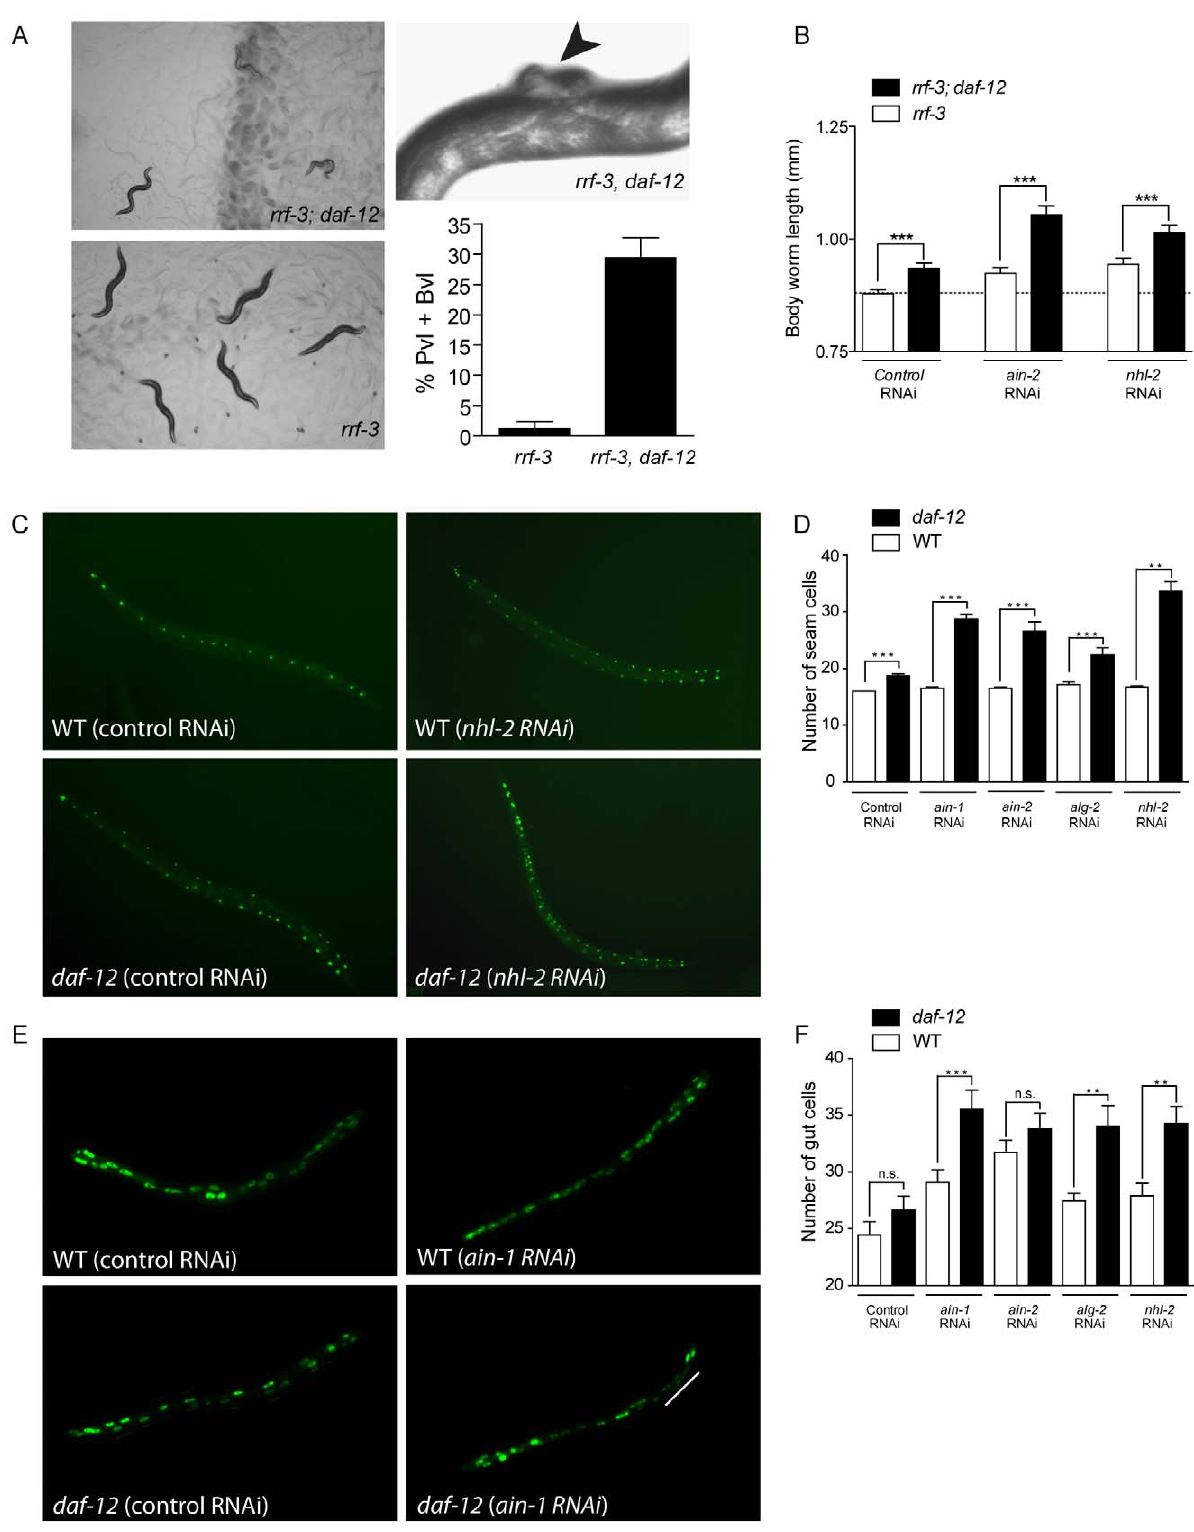
Figure 6. daf-12(0) worms are sensitized to changes in miRISC activity. ( A ) (Left panels) Images of ain-1 RNAi treated rrf-3 or rrf-3; daf- 12(rh61rh411) worms. (Upper right) Photo showing protruding vulva phenotype (arrow). Graph showing effects of ain-1 RNAi treatment on vulva development. ( B ) Body length was analyzed in rrf-3 or rrf-3; daf-12(rh61rh411) worms treated with ain-2 or nhl-2 RNAi. ( C ) Effect of control and nhl-2 RNAi on WT or daf-12(rh61rh411) worms carrying SCM::GFP transgene marking seam cells. ( D ) Quantification of seam cells in worms treated with miRISC RNAi. ( E ) Effect of ain-1 RNAi on WT or daf-12(rh61rh411) worms carrying an elt-2::GFP transgene marking intestinal nuclei. White bar indicates abnormal extra division. ( F ) Quantification of intestinal cells in worms treated with miRISC RNAi. Bars denote standard error of mean (SEM). P-values were determined by Student’s t-test. ** p , 0.01, *** p , 0.001, n.s. (difference is not statistically significant). doi:10.1371/journal.pgen.1002179.g006 PLoS Genetics | www.plosgenetics.org 9 July 2011 | Volume 7 | Issue 7 |